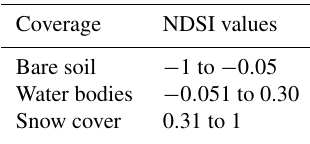
Table 1. NDSI discrete values for avalanche depositional zone de-